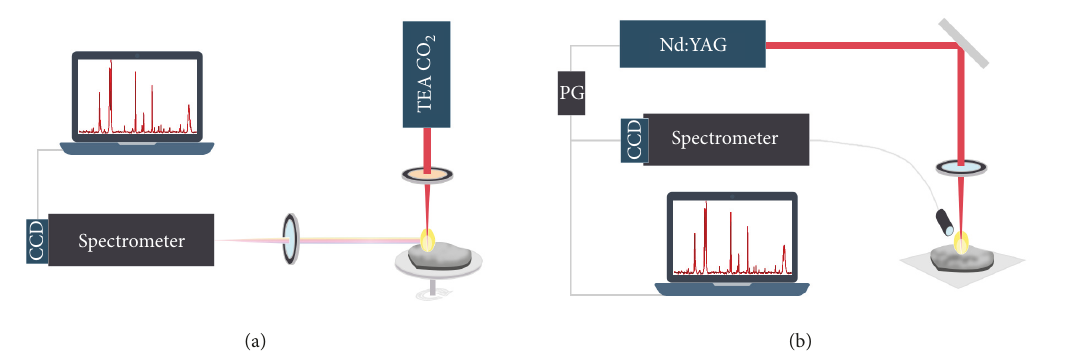
Figure 1: Schematic diagram of the experimental setup used for LIBS analysis. (a) TEA CO 2 laser, nongated signal detection; (b) Nd:YAG laser, gated signal